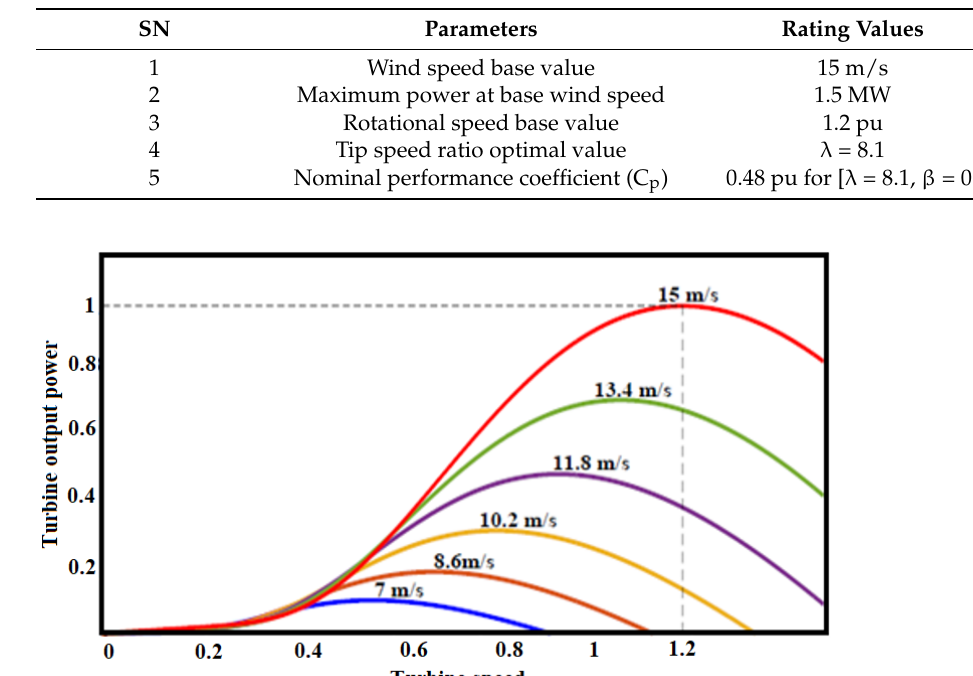
Figure 8. Typical P- ω curve of the WT for various wind speeds.